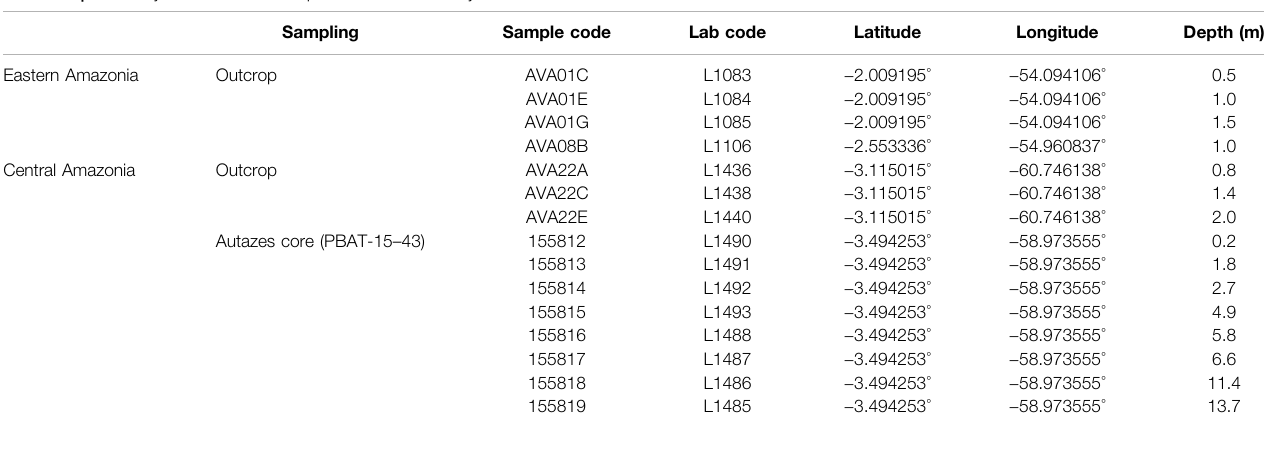
TABLE 1 | Summary information of samples used in this